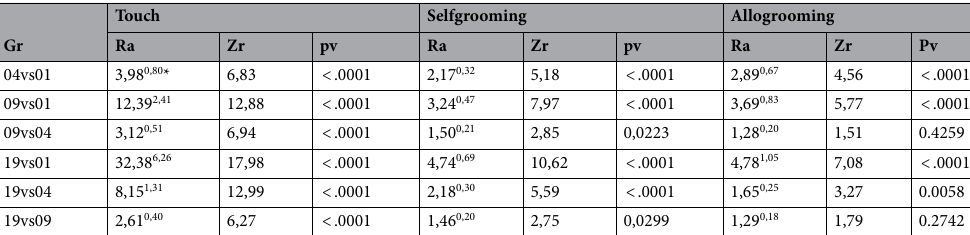
Table 2. Multiple comparison tests for groups (Gr.) 4:1 (04 vs. 01), 09:01 (09 vs. 01), 09:04 (09. vs. 04), 19:01 (19. vs. 01 ), 19:04 (19. vs. 04) and 19:09 (19. vs. 09) of Atta sexdens rubropilosa (Hymenoptera: Formicidae) workers and the values of ratio (Ra.) (Mean + standard error), z.ratio (Zr), p .value (pv) on touch, selfgrooming, and allogrooming behaviors. *Superscripted values are the standard error of the mean (Ra).